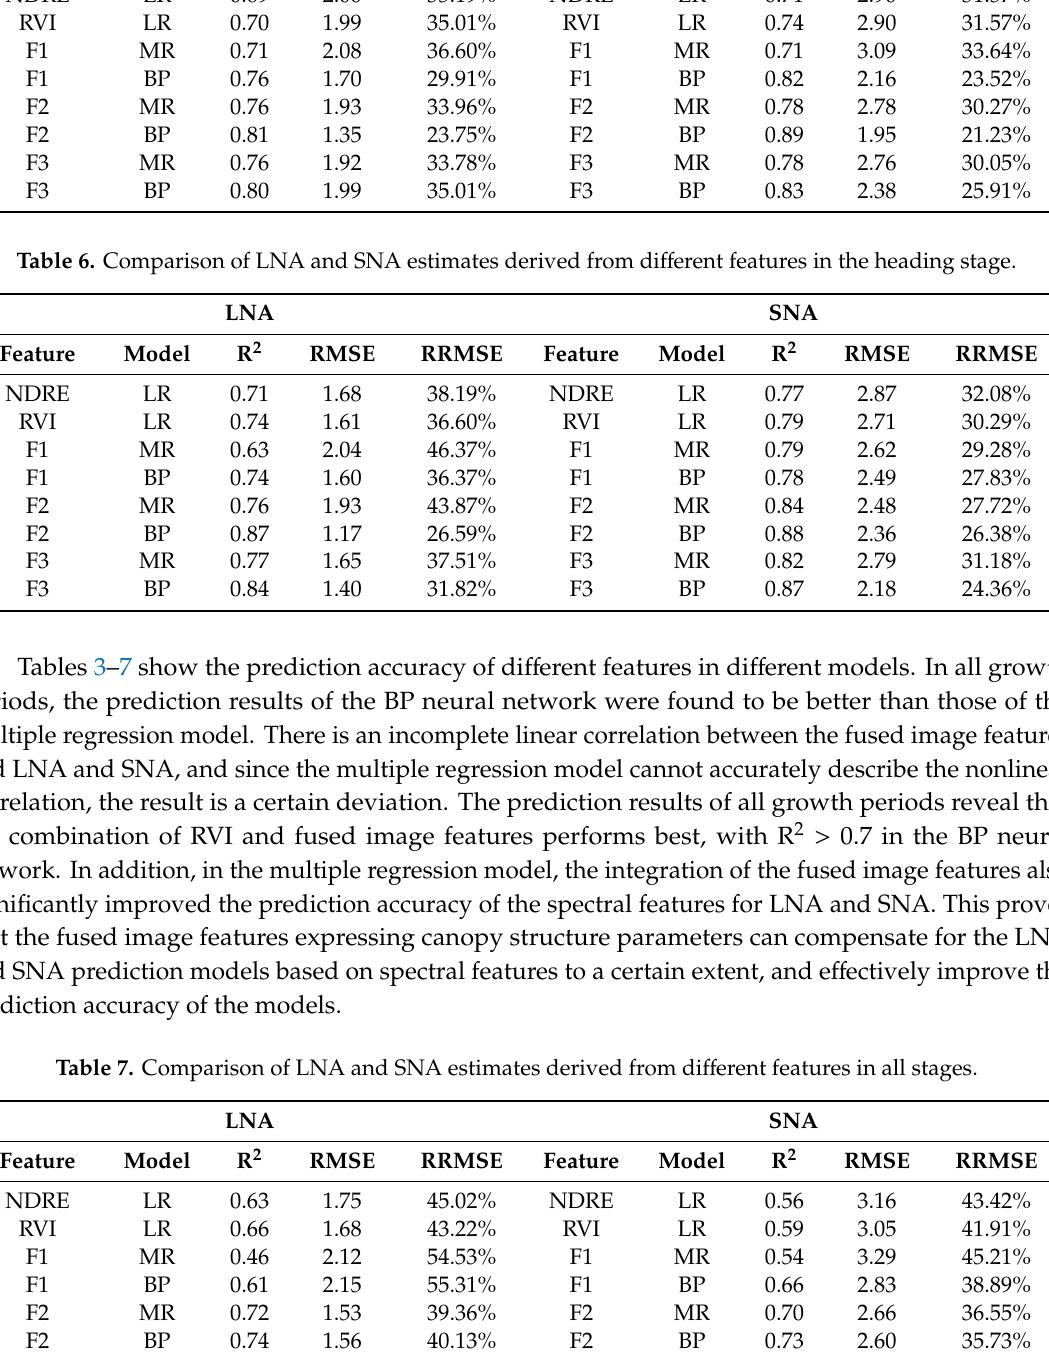
Table 5. Comparison of LNA and SNA estimates derived from di ff erent features in the booting stage. LNA Feature